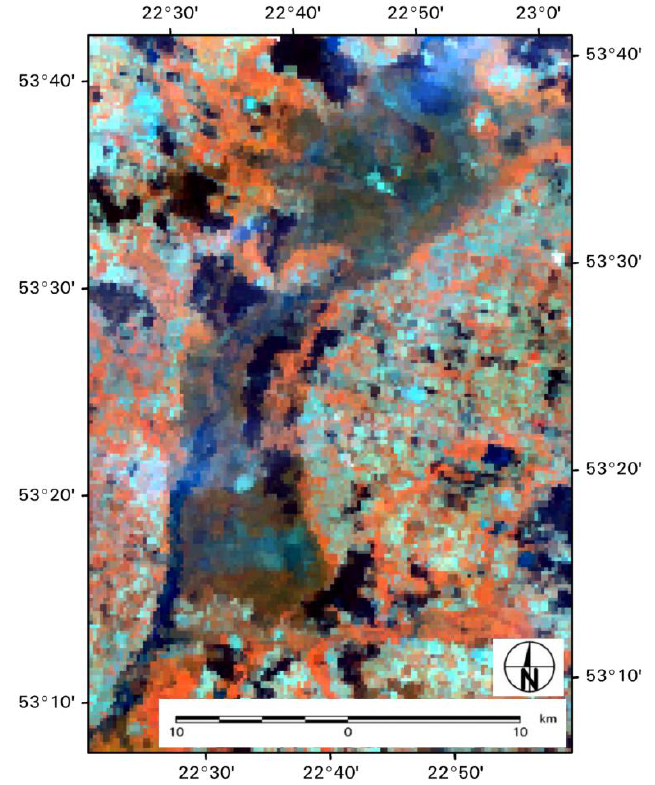
Figure 5. RGB (10, 5, 3) composition of MERIS image acquired on 25 April